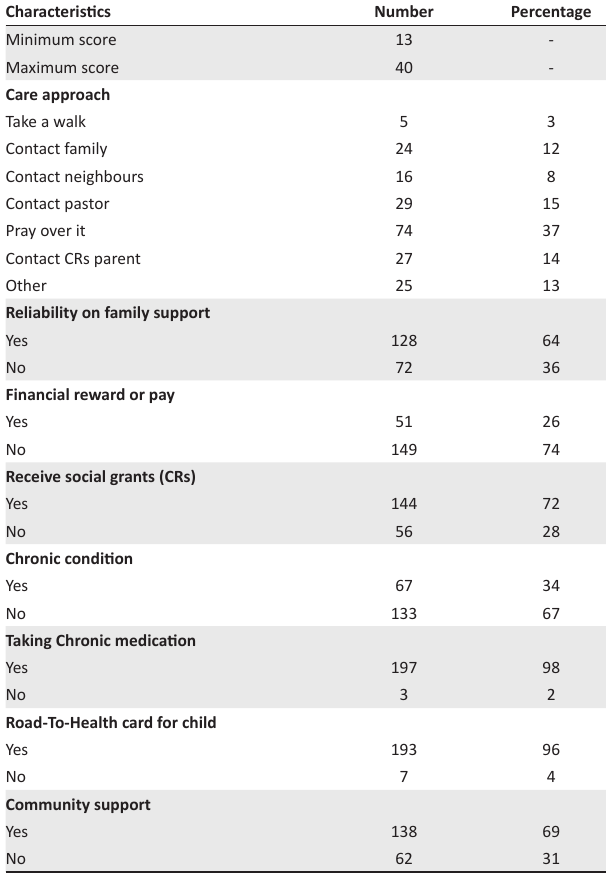
TABLE 1: Female caregiving burden mediators ( n =